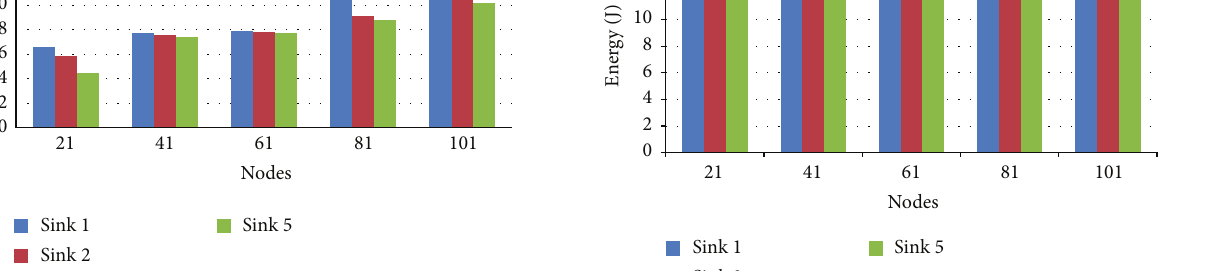
Figure 4: Nodes versus delay in terms of sink.